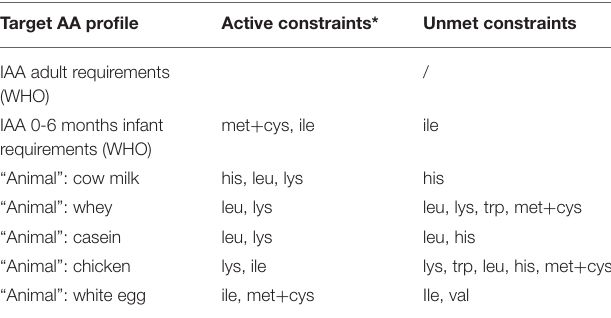
TABLE 1 | Active constraints during linear programming, which led to infeasible solutions and to unmet non-active